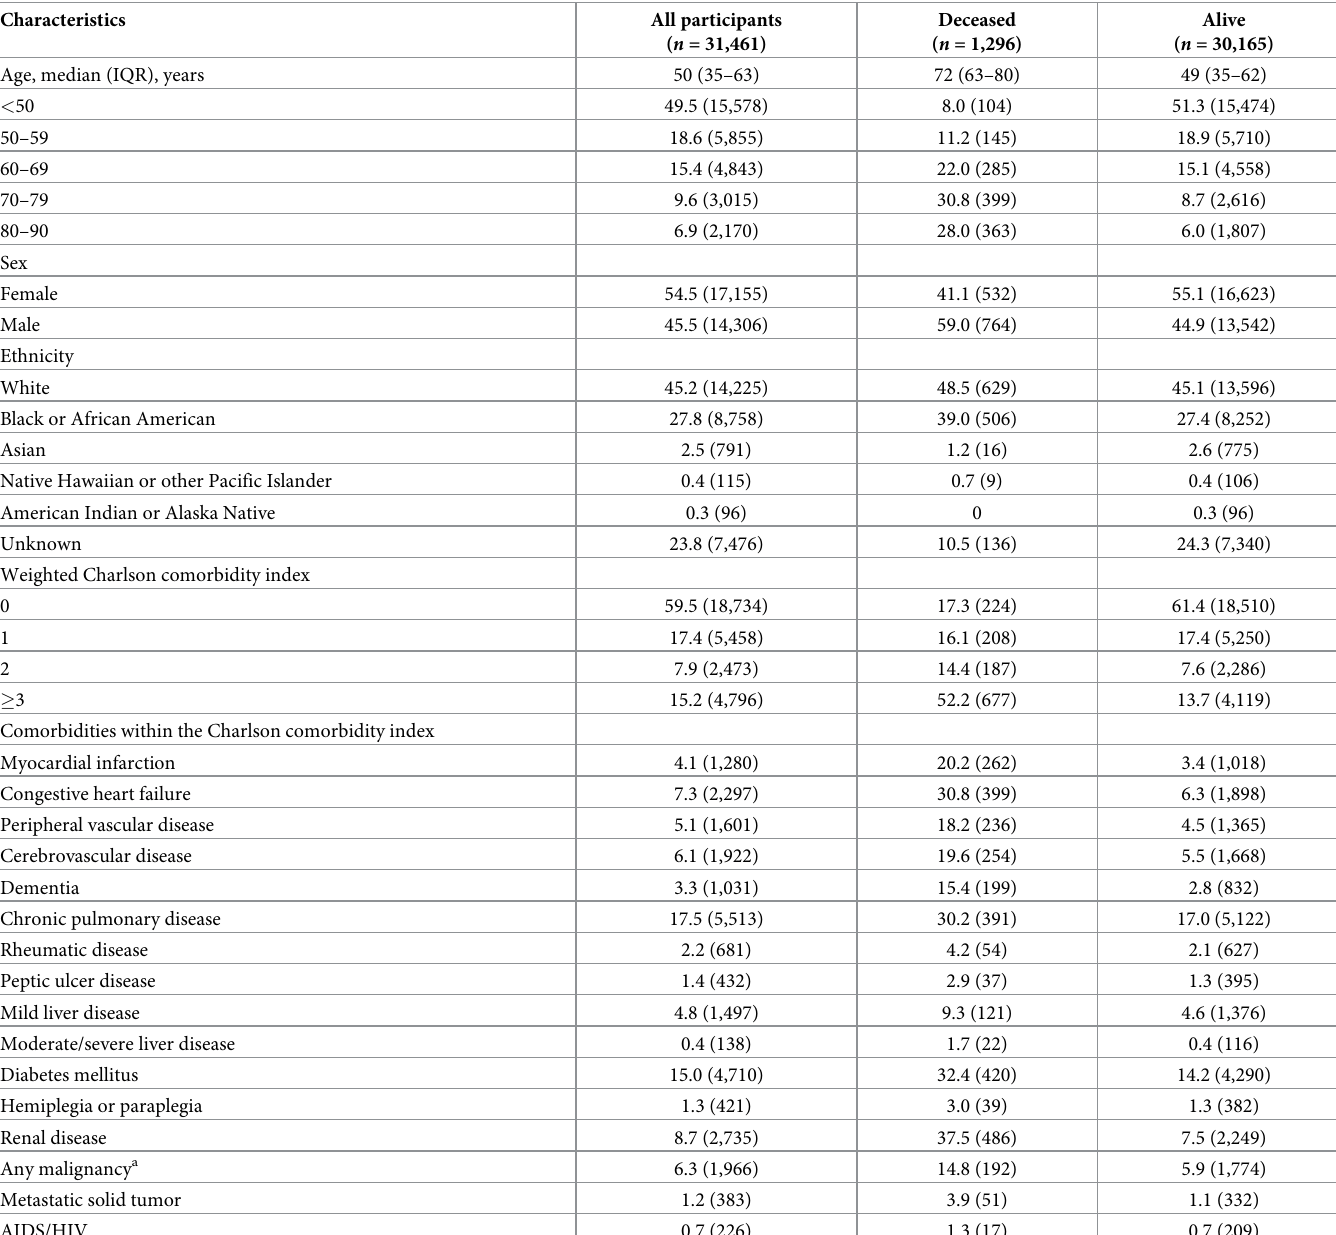
Table 1. Baseline characteristics of patients with COVID-19 in the TriNetX research network as of May 26, 2020.